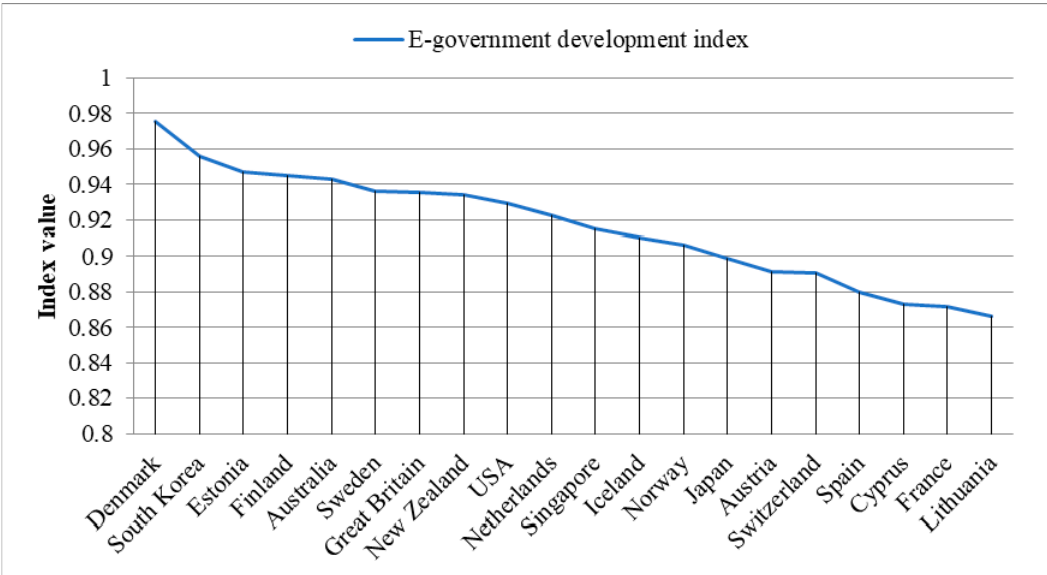
Figure 2. Rating of countries by the e-government development index in 2018. Source: Compiled based on the UN 2020 e-government development index (UNDESA 2021). Table 2. Reserved World Bank funds by sectors of the economy in 2015–2019, billion dollars, percentage.